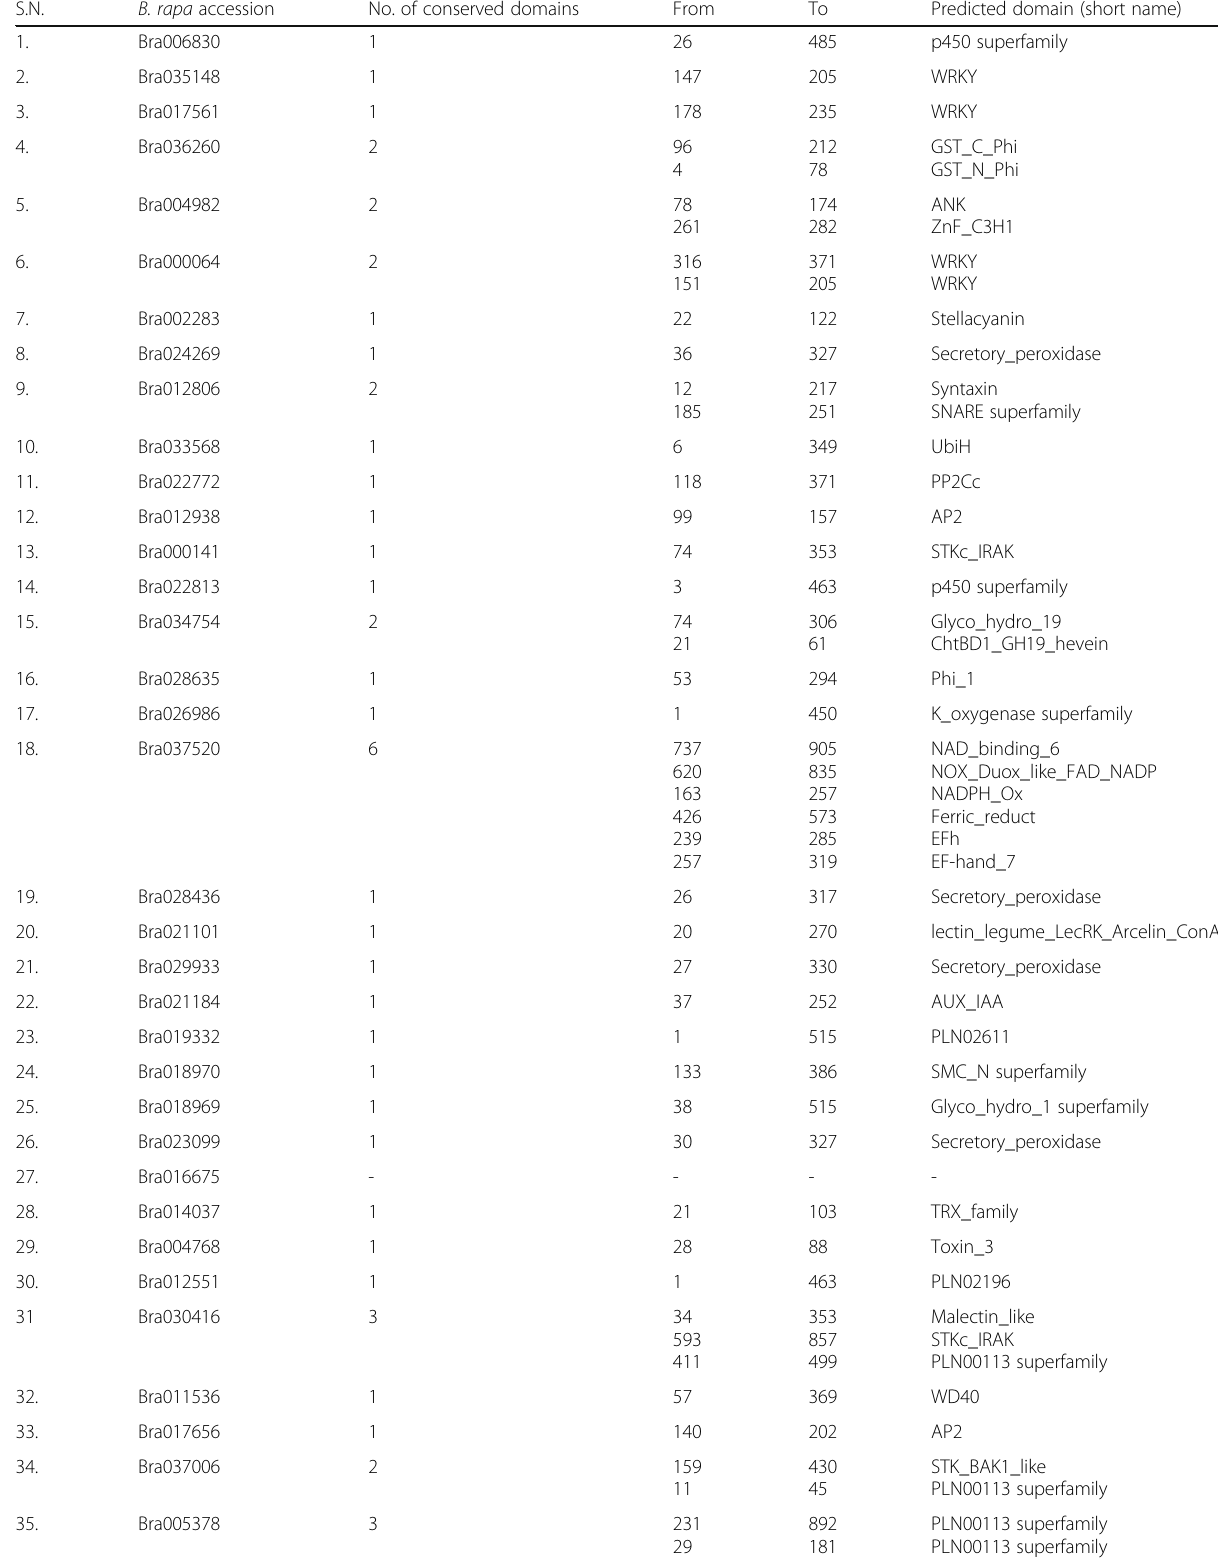
Table 4 Predicted conserved domains in identified upregulated Brassica rapa sequences with their positions under contrast SAMC